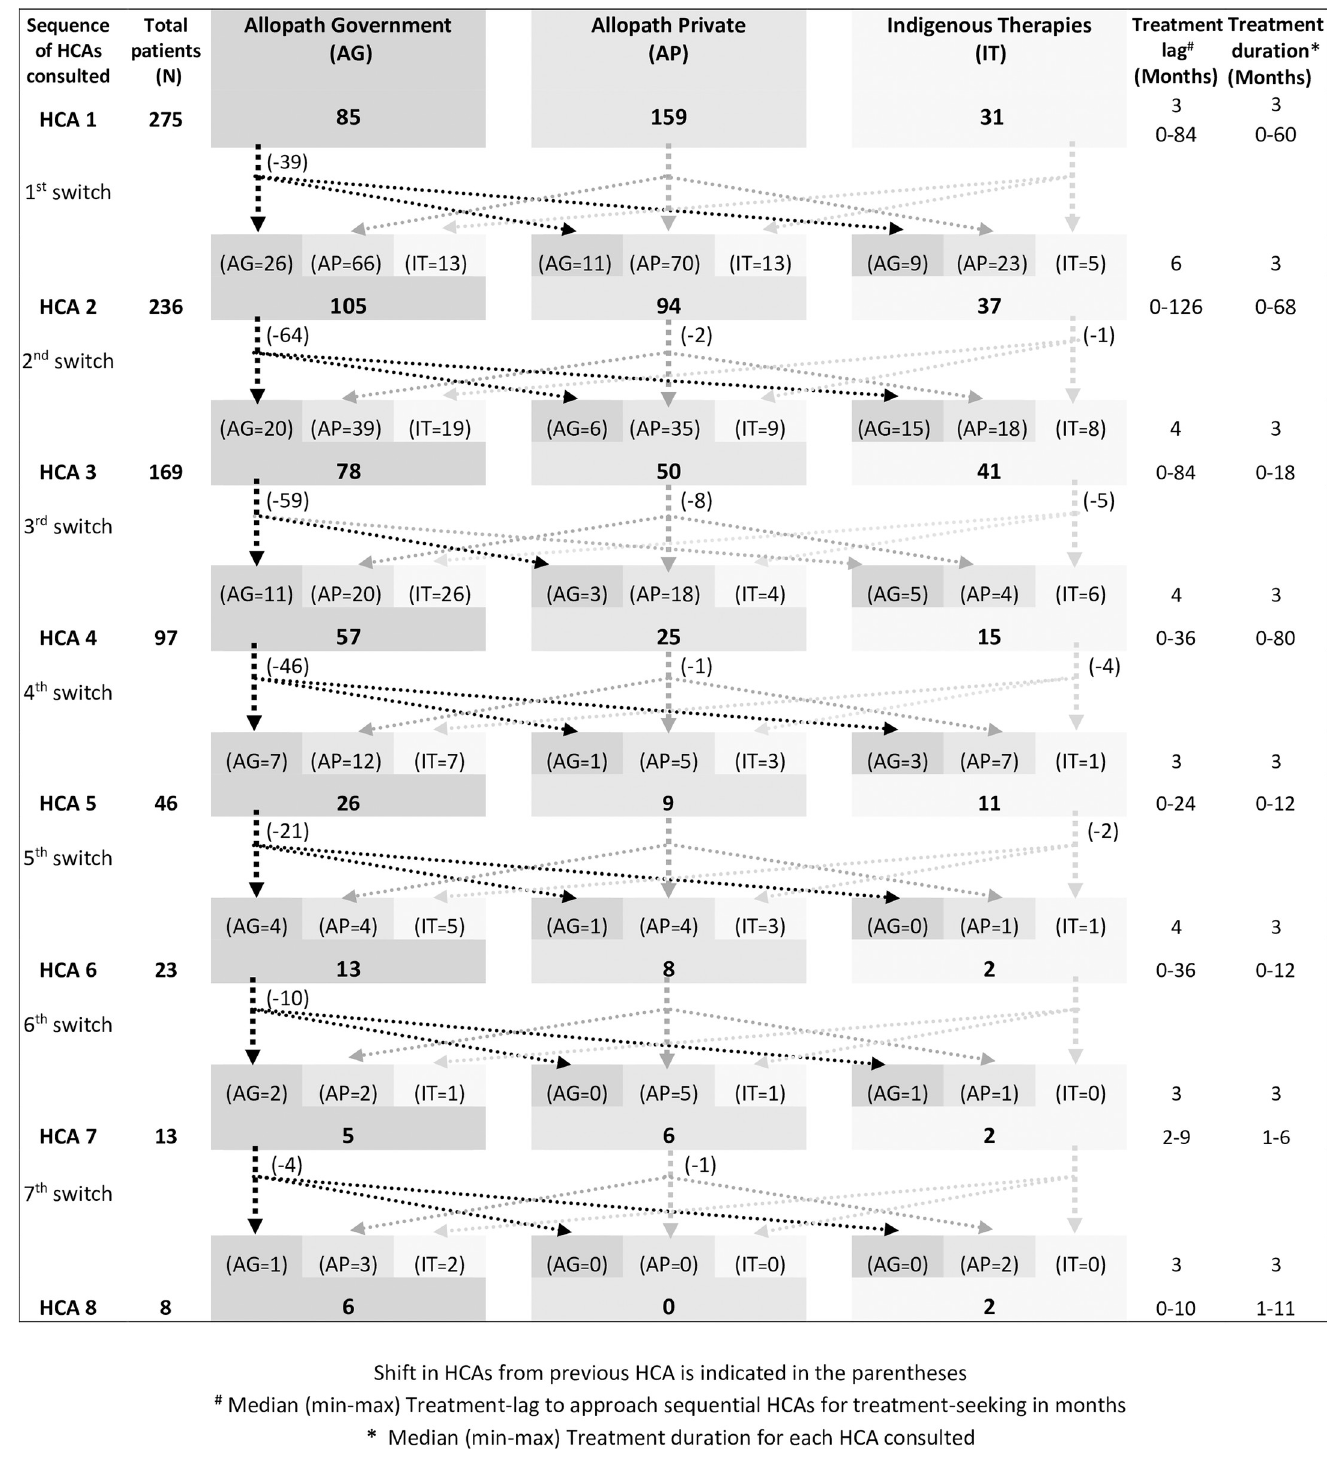
Fig 2. Pattern of switching between Health Care Agencies (HCAs) by females with PCOS.